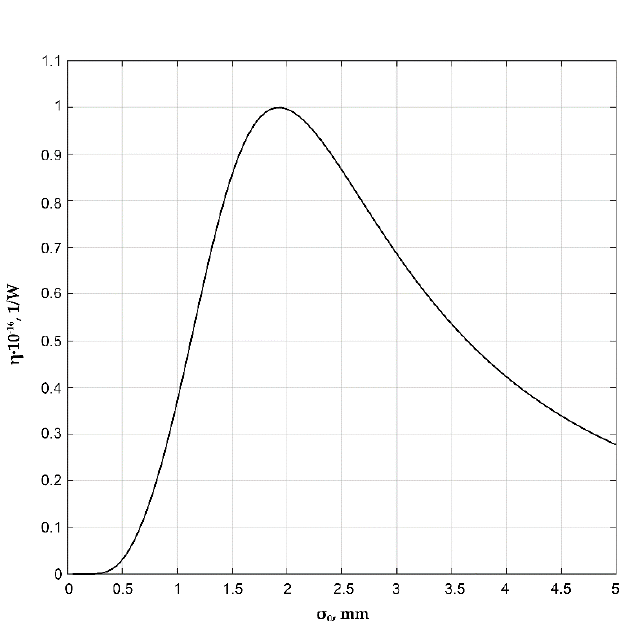
Figure 4. Dependence of the efficiency exponent η of a radio vorte x beam on the difference fre- quency f of laser beams for three different values of the laser beam waist radius.